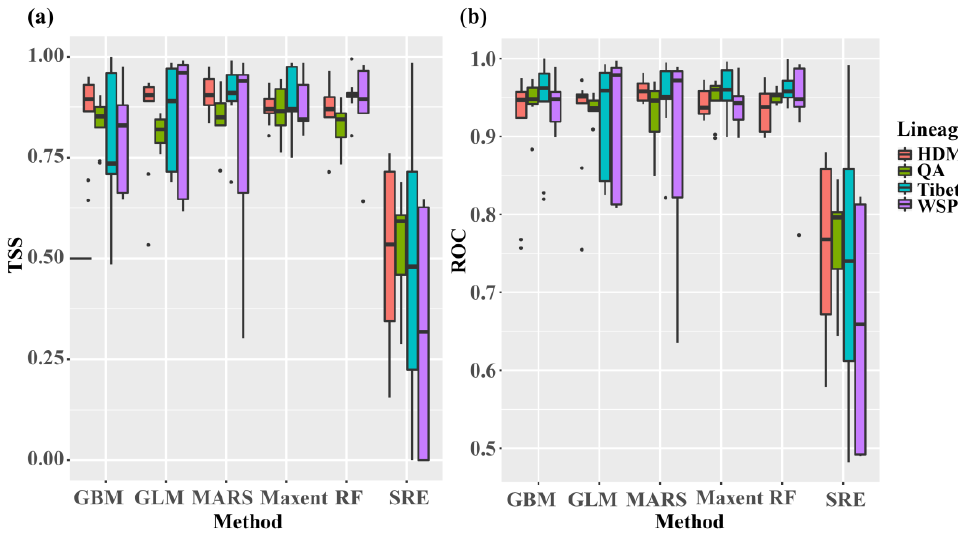
Figure 2. The results of TSS ( a ) and ROC ( b ) when evaluating single models for the distribution ranges of the three lineages of Quercus aquifolioides and this species with current climatic variables. HDM, Hengduan Mts.; QA, Quercus aquifolioides ; WSP, West Sichuan Plateau.